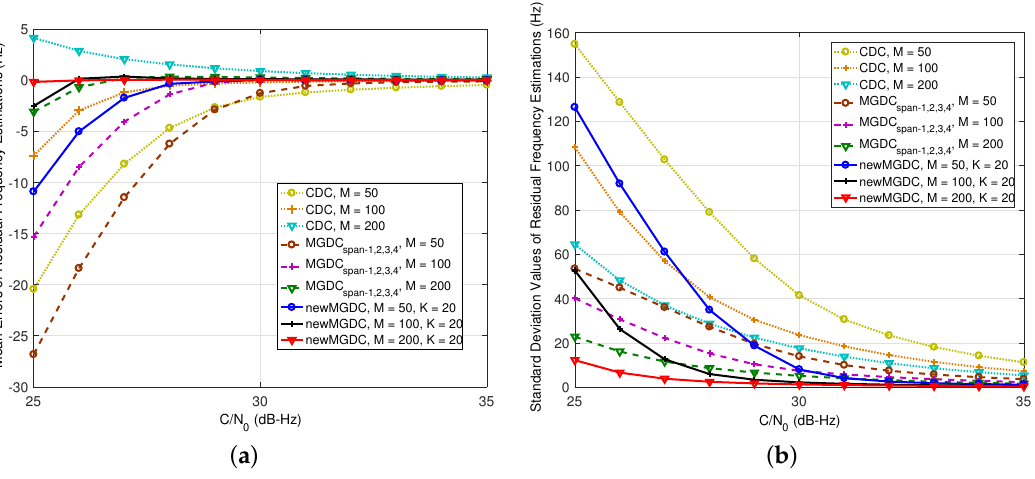
= 100 Hz, T = 1 ms). coh d